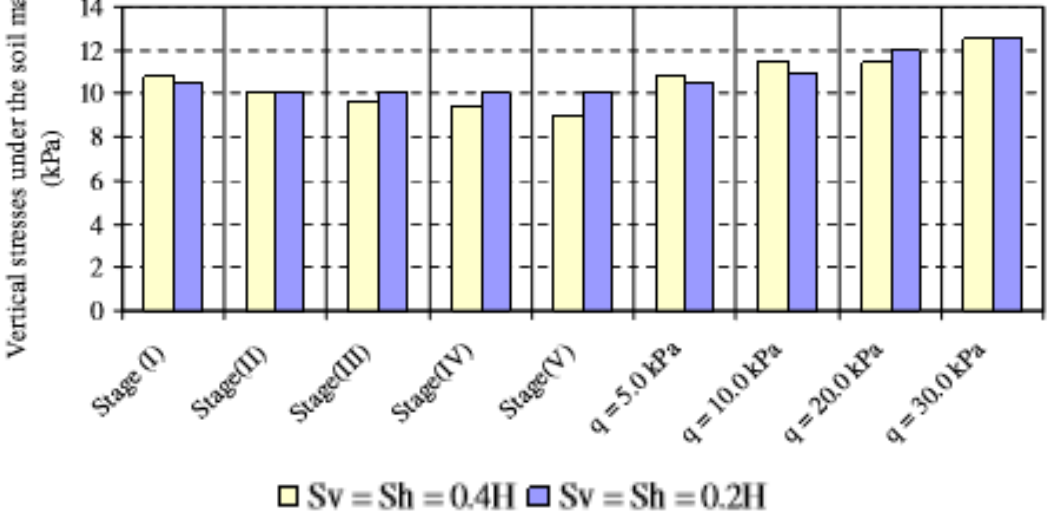
Figure 26. Influence of nail inclination on the slope face vertical stresses at mid height of